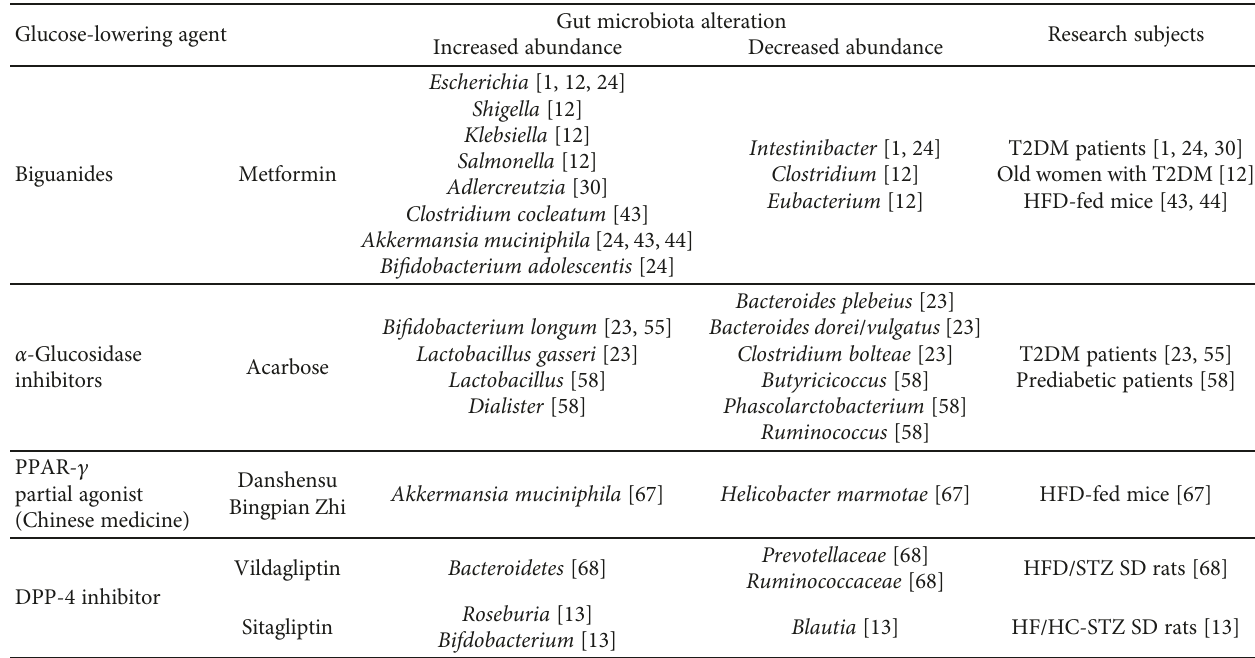
Table 1: Glucose-lowering agents and associated gut microbiota